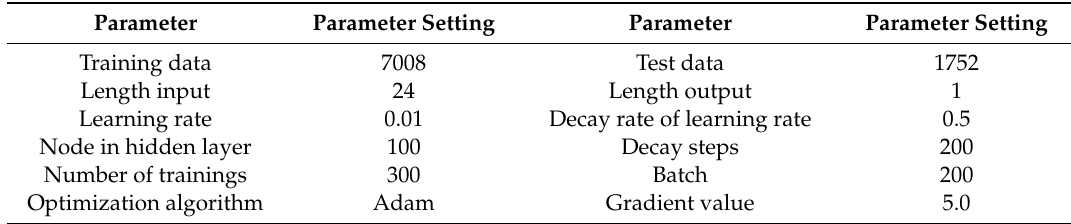
Table 2. Setting of model parameters.